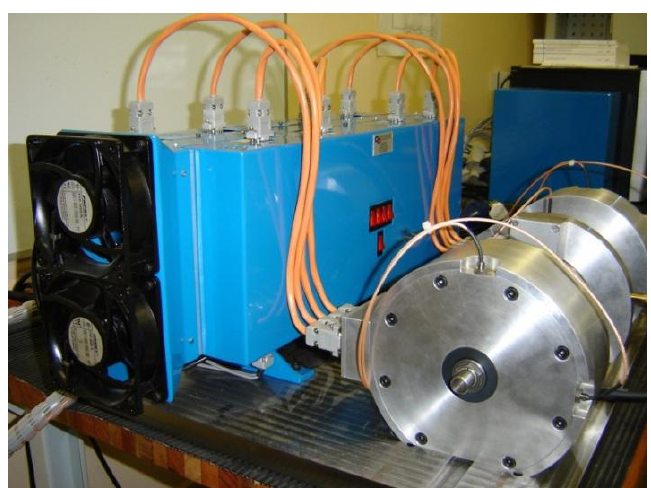
Figure 8. Experimental double heteropolar